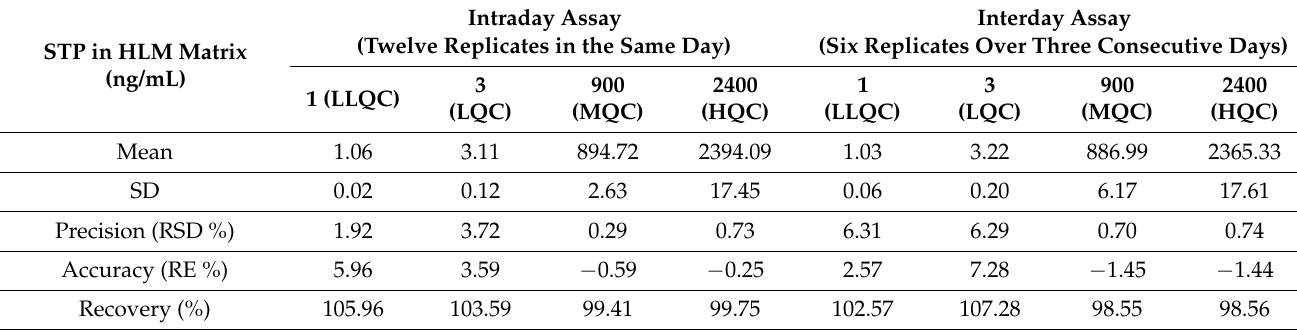
Table 3. Precision and accuracy (intraday and interday) results of established method.